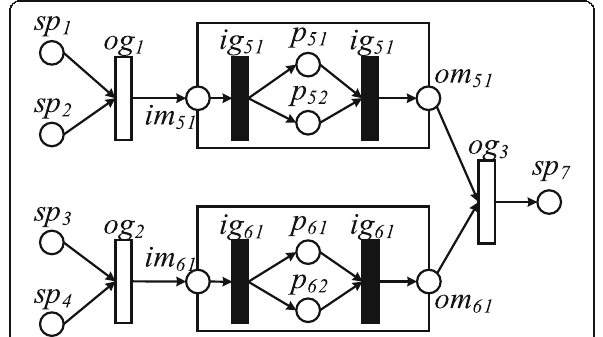
Fig. 9 COP model generated based on attack scenario information